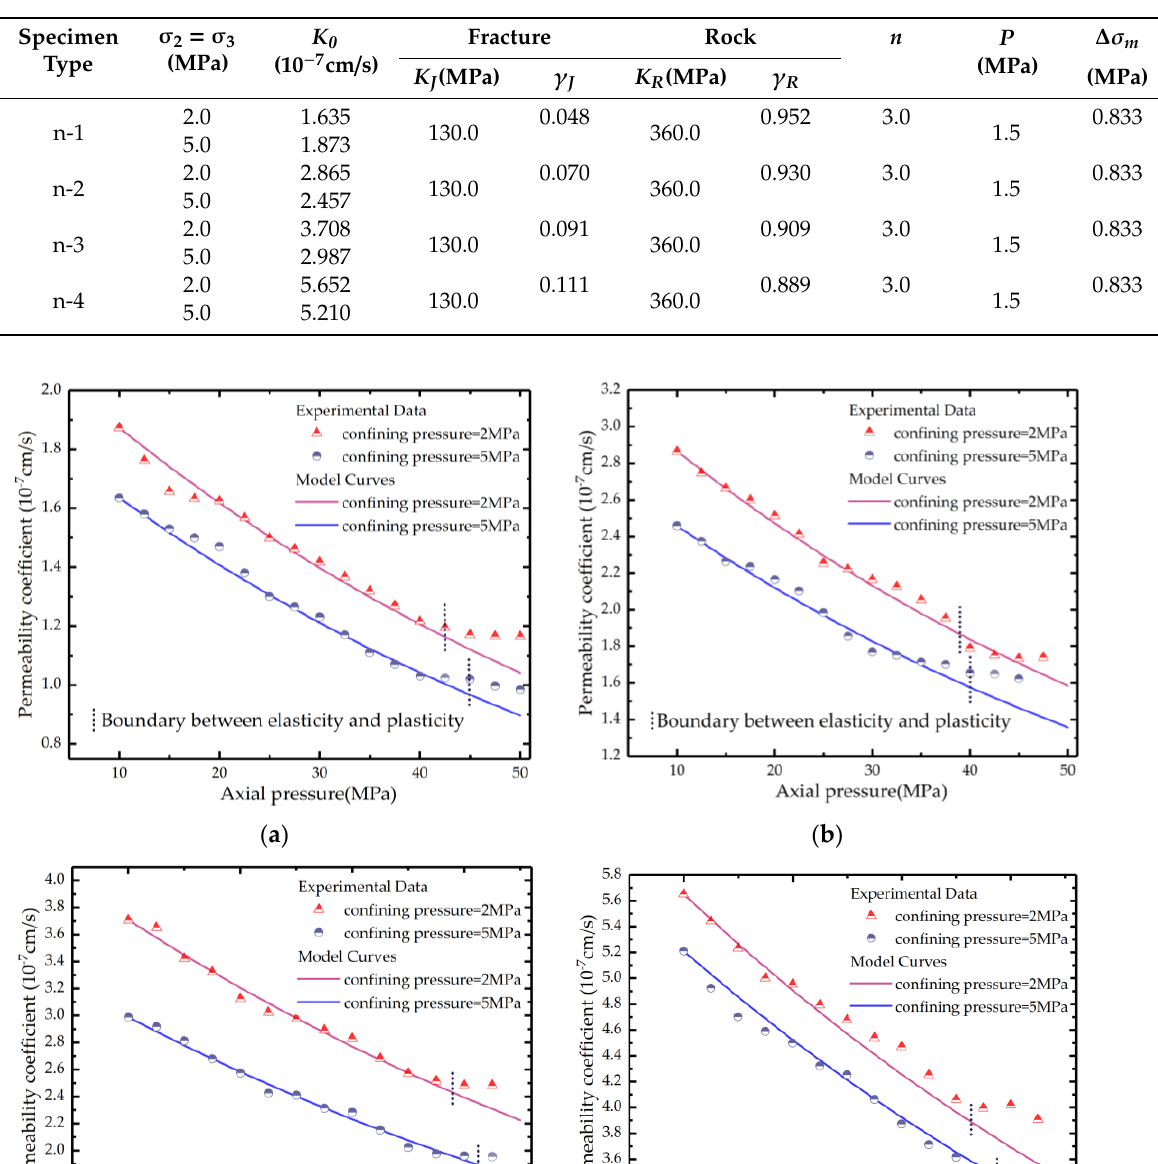
Table 1. Parameter values of the permeability model.